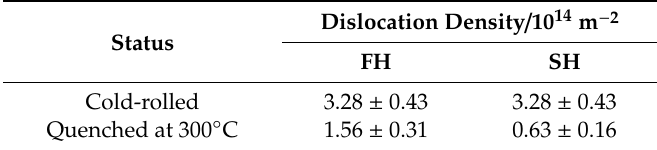
Table 2. The dislocation densities of cold-rolled sample and samples quenched at 300 ◦ C during fast and slow heating.